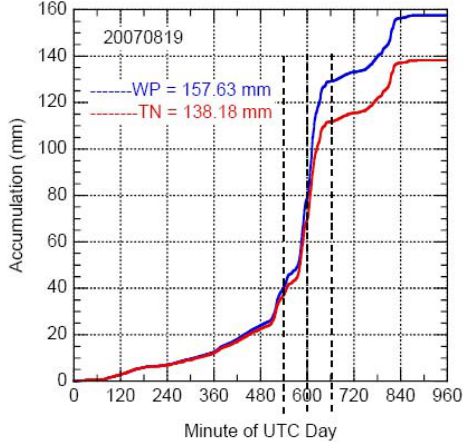
Fig. 4 One-minute rain accumulations at Norman, OK, August 19, 2007. WP is in the Fig. 4. One-min rain accumulations at Norman, OK, 19 Au- pit and TN is at the Norman Mesonet site. The dashed vertical lines define two gust 2007. WP is in the pit and TN is at the Norman Mesonet site. successive 60-minute periods. The dashed vertical lines define two successive 60-min